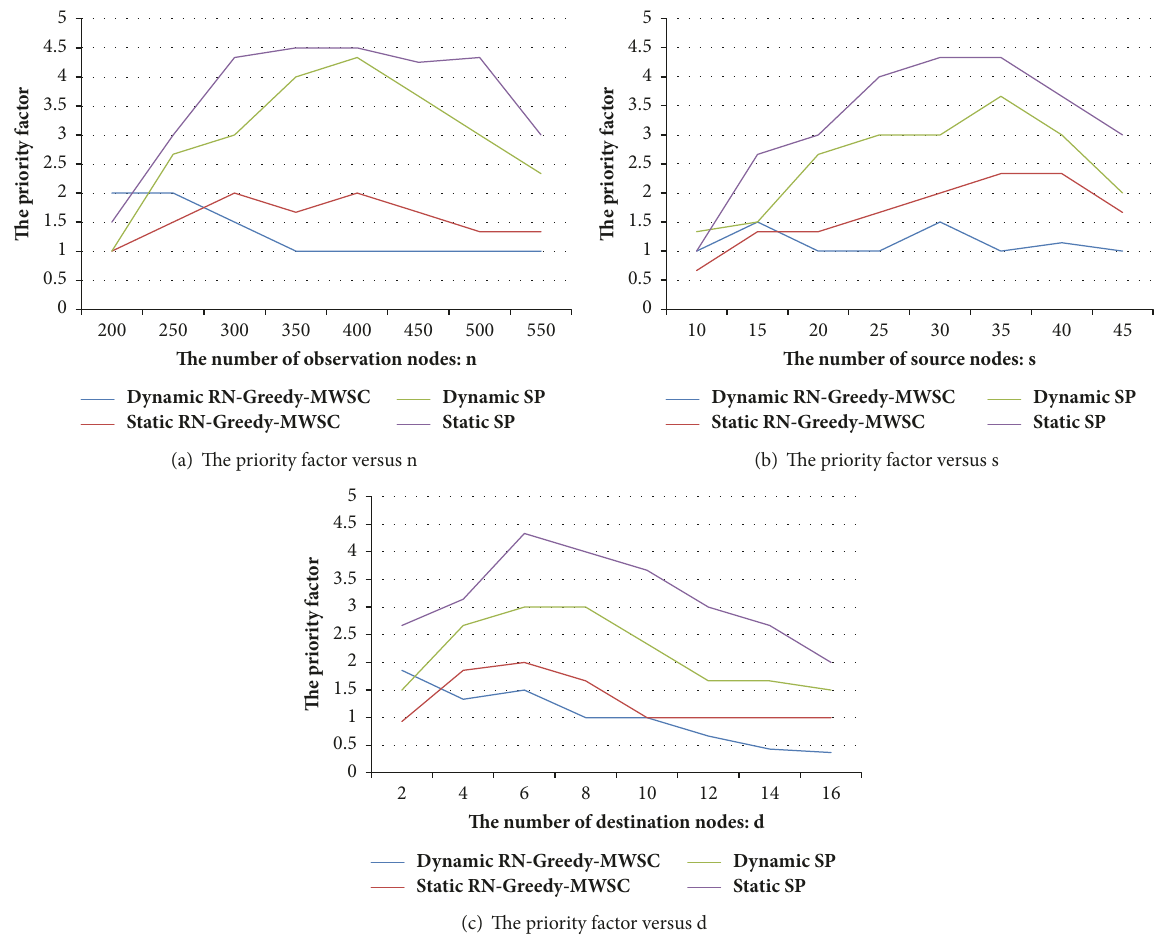
Figure 3: Performance on the priority